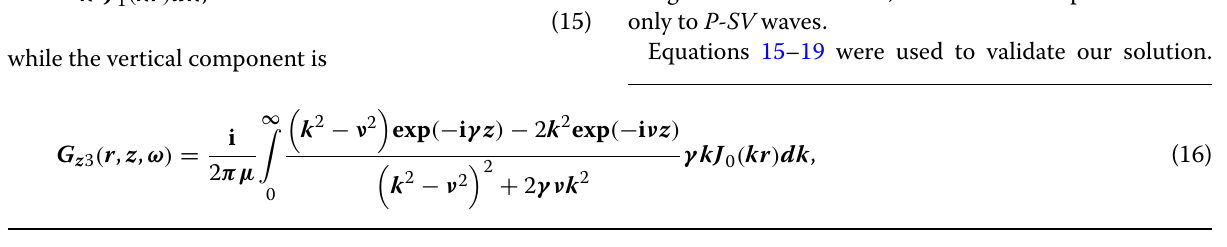
for radial, transverse and vertical components, respec- tively. The first two components display the contributions of P - SV and SH waves in the corresponding wavenumber integrals. As it should be, the vertical component is due only to P - SV waves.